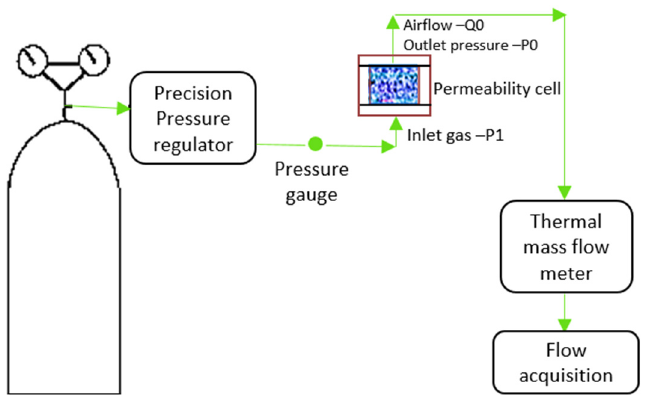
Figure 17. Experimental apparatus for permeability testing (Reproduced with permission from reference [21]).